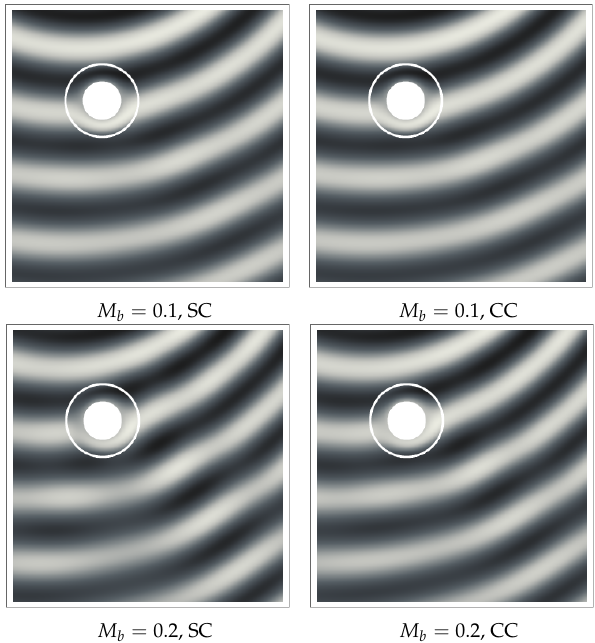
Figure 12. Field of total pressure in Ω c ∪ Ω h . Comparison of results obtained with static (SC) and convected (CC) cloaks at ka = 3.4.